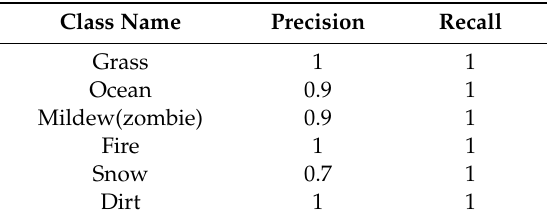
Table 11. Precision and recall for each class.